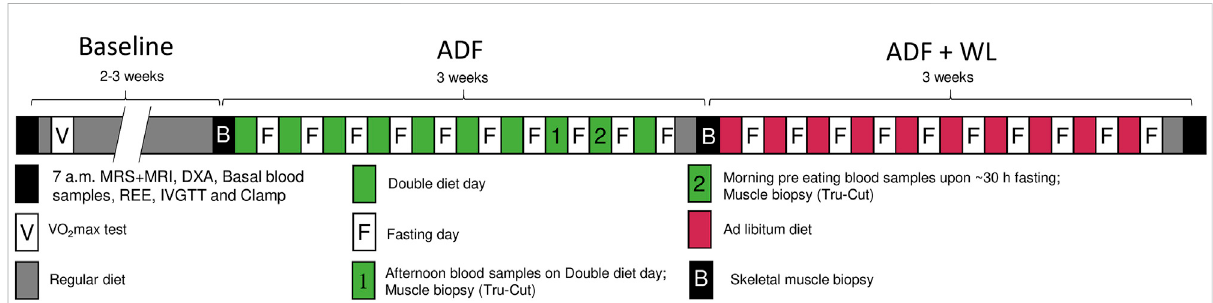
FIGURE 1 Study protocol. Two baseline experimental days were performed (black boxes) comprising of magnetic resonance spectroscopy ( 1 H-MRS) and magnetic resonance imaging (MRI) (only one time at baseline), body composition (dual-energy X-ray absorptiometry (DXA) scan), fasting blood sampling, resting energy expenditure (REE), intravenous glucose tolerance test (IVGTT), and a euglycemic, hyperinsulinemic clamp These measurements were repeated after 3 weeks of alternate days fasting (ADF). During fast days (midnight continuing for 30 h until 06.00 the following day) zero calorie intake was allowed, and during the eating days, the participants ate the double amount of food. Bodyweight was measured every morning and the diet was adjusted accordingly so that no change in body weight should occur. Blood was sampled and Tru-Cut micro muscle biopsies were obtained on two occasions, one in the afternoon on a double diet day (marked 1), and one in the morning after fasting (marked2).Subsequently.Inthefollowing3 weeks,ADFwascontinued, howeverwithnodietaryrestrictions,i.e.thestudyparticipantswereallowed to lose bodyweight (ADF + WL). On the second baseline experimental day and following ADF (marked B), muscle biopsies were obtained before the IVGTT and after the clamp, in addition to the other procedures described. All tests were performed at the same time of day, at Baseline, ADF and at ADF + WL. Maximal oxygen uptake (VO 2 max) was measured at the study start to document a similar level of physical activity among all study